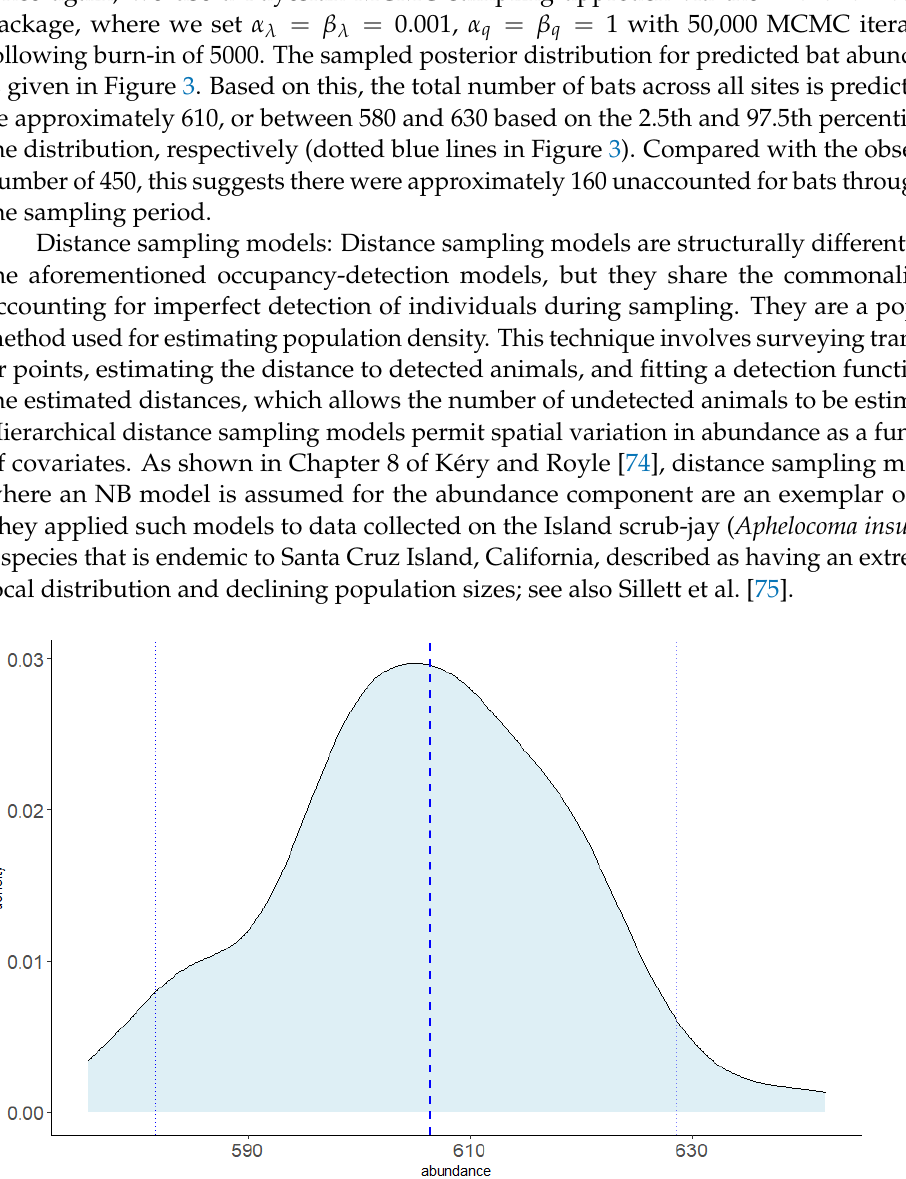
Figure 3. Sampled posterior distribution for predicted bat abundance when fitting a Poisson-gamma N -mixture model with no covariates. In this example, we combined all species counts and account for imperfect detection as well as overdispersion. Based on the median (blue dashed line), the predicted bat abundance is just below 610. The dotted blue lines represent the 2.5th and 97.5th percentiles of the distribution,